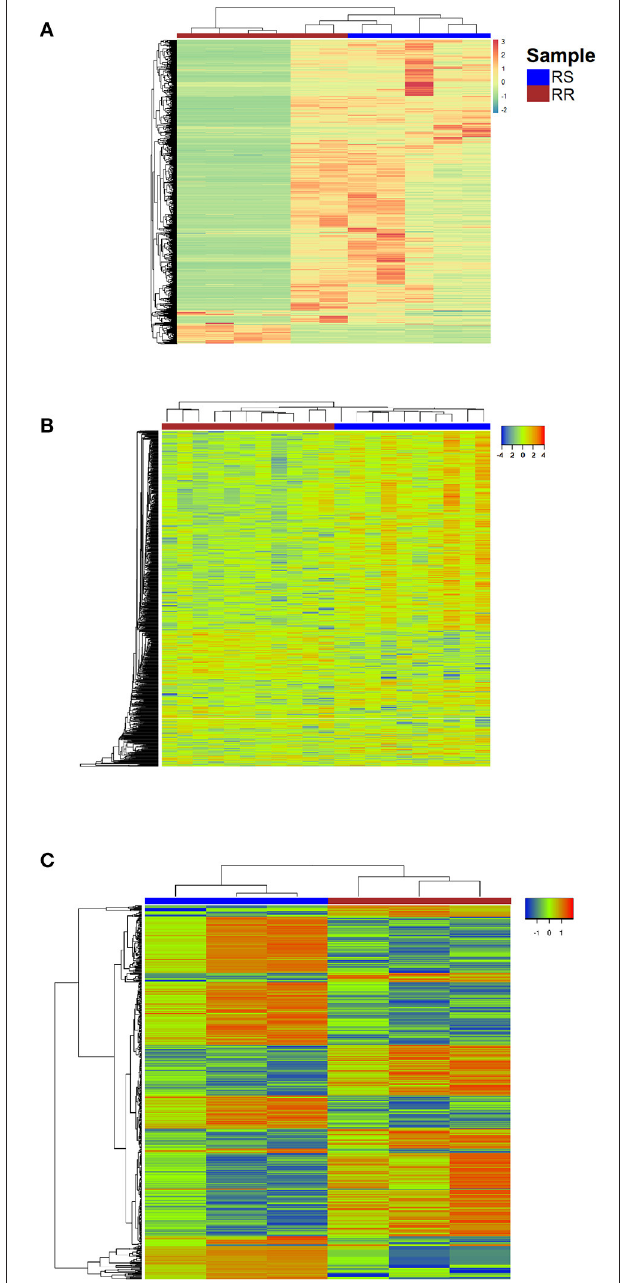
FIGURE 2 | Heatmap representing color-coded expression levels of DEGs for the datasets (A) GSE120798 (breast cancer), (B) GSE13280 (ALL), (C) GSE97543 (COAD); columns correspond to samples and rows correspond to genes. RR, Radioresistant; RS, Radiosensitive.